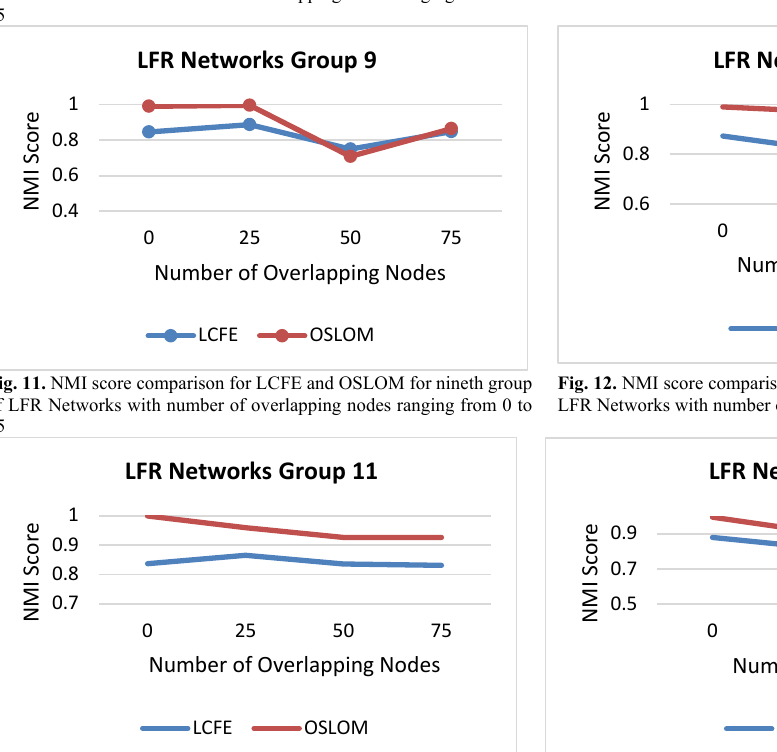
Fig. 14. NMI score comparison for LCFE and OSLOM for twelveth group of LFR Networks with number of overlapping nodes ranging from 0 to 75